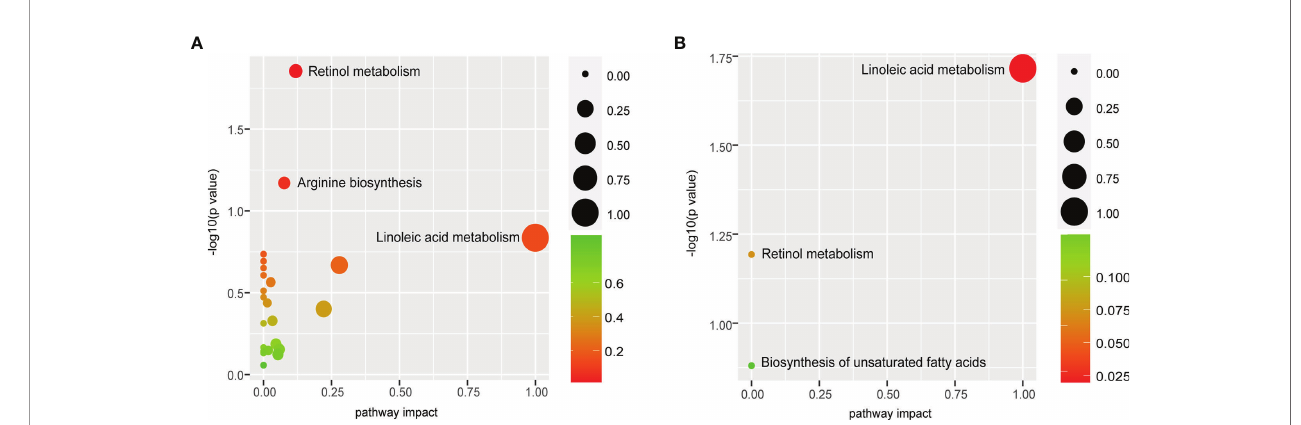
FIGURE 6 | Retinol metabolism and linoleic acid metabolism are common features of ESCC patients. (A) Pathway analysis of commonly altered 105 metabolites from patients versus controls revealed that retinol metabolism was the most perturbed pathway. (B) Pathway analysis of 18 biomarkers displayed that the most signi fi cant pathway was linoleic acid metabolism. Pathway analysis module of MetaboAnalyst 5.0 was used to perform the pathway enrichment analysis ( y -axis, enrichment p -values) and the pathway topology analysis ( x -axis, pathway impact values indicating centrality and enrichment of a pathway). Circle color represents enrichment signi fi cance with darker color indicating a higher level of signi fi cance, and circle size correlates with pathway impact value of the pathway.